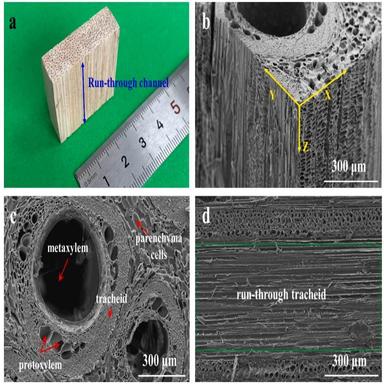
(a) Digital image of natural bulk rattan, (b) SEM image showing the three sections of bulk rattan, (c) SEM cross-sectional image of natural bulk rattan, (d) SEM longitudinal section image of natural rattan, revealing some run-through tracheid cells.